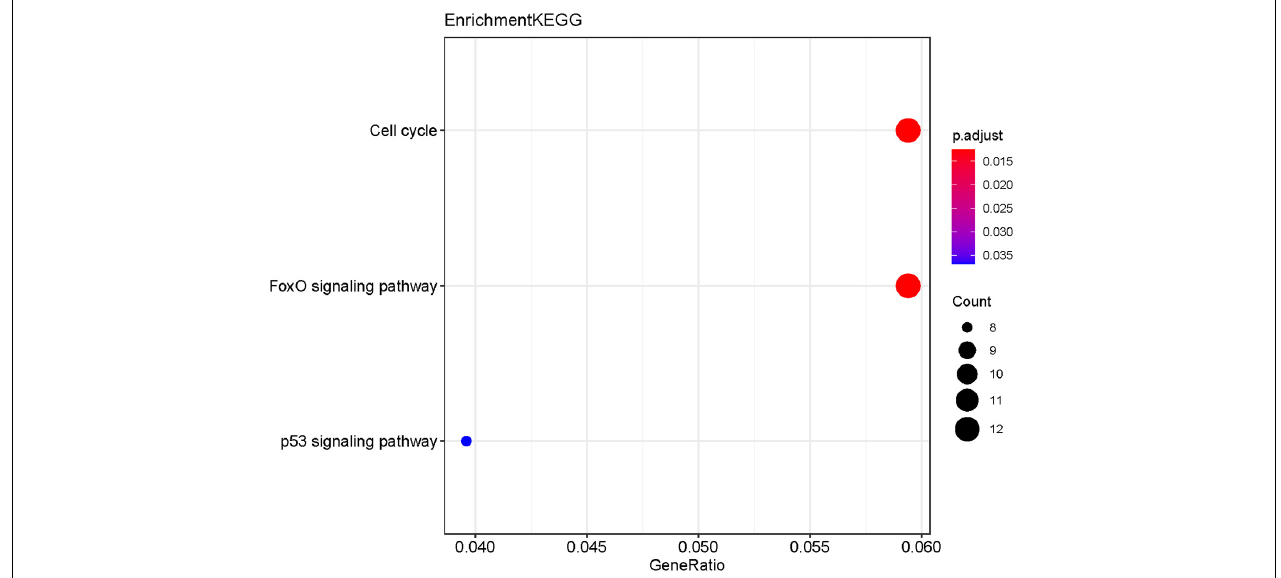
FIGURE 7 | KEGG pathway analysis of the collection of the potential target genes of the DE-miRNAs (miR-492, miR-590-3p, and miR-631). The results show the enriched pathways of the target genes include cell cycle, FoxO signaling pathway, and P53 signaling